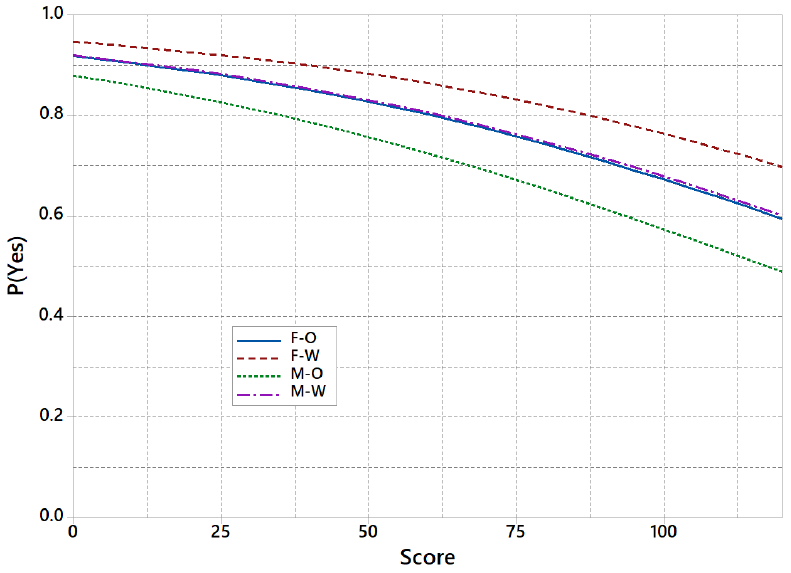
Figure 10. Adjusted model for P(Yes) vs Score by